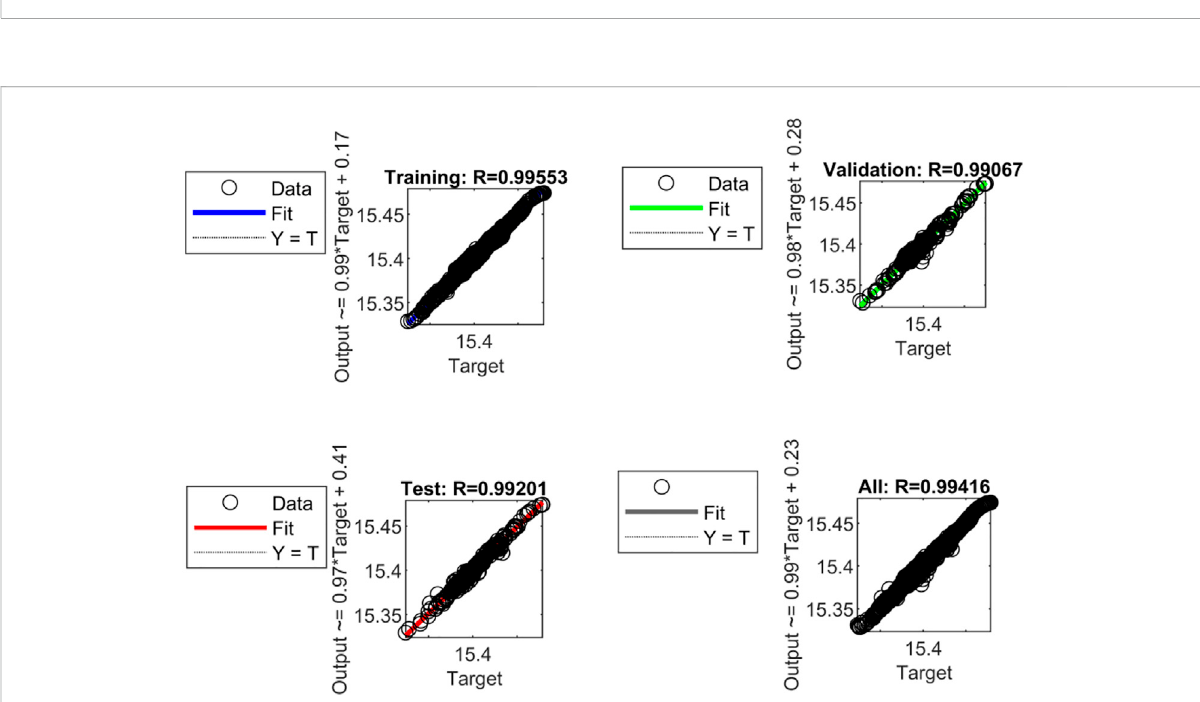
FIGURE 9 Linear regression relations between the predicted values and the target values for the